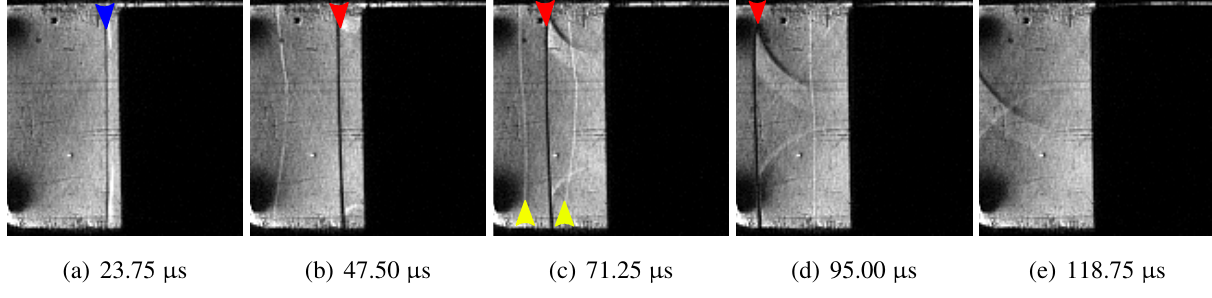
Figure A1. Closed cell foam, Case NC.